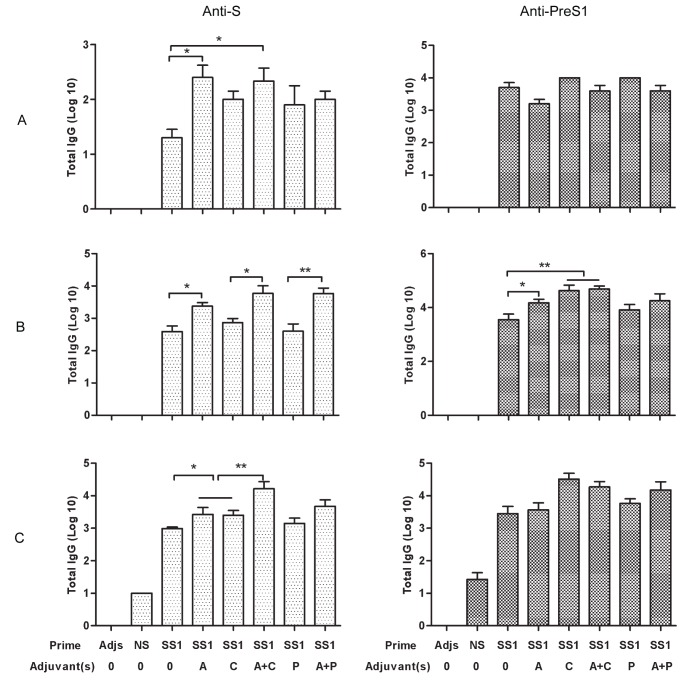
Antibody responses in immunised mice.(A) Antisera were collected at 2 weeks after the 2nd priming; (B) Antisera were collected at 2 weeks before rAdSS1 boosting; (C) Antisera were collected at 2 weeks after rAdSS1 boosting. Total IgG titres specific for the HBV antigen were determined by ELISA as described in the Methods section. Statistical significance was analysed and shown as **p<0.01 and *p<0.05. SS1: HBSS1. A, alum; C, CpG; P, poly(I:C). Adjs: control group with adjuvants mixture.